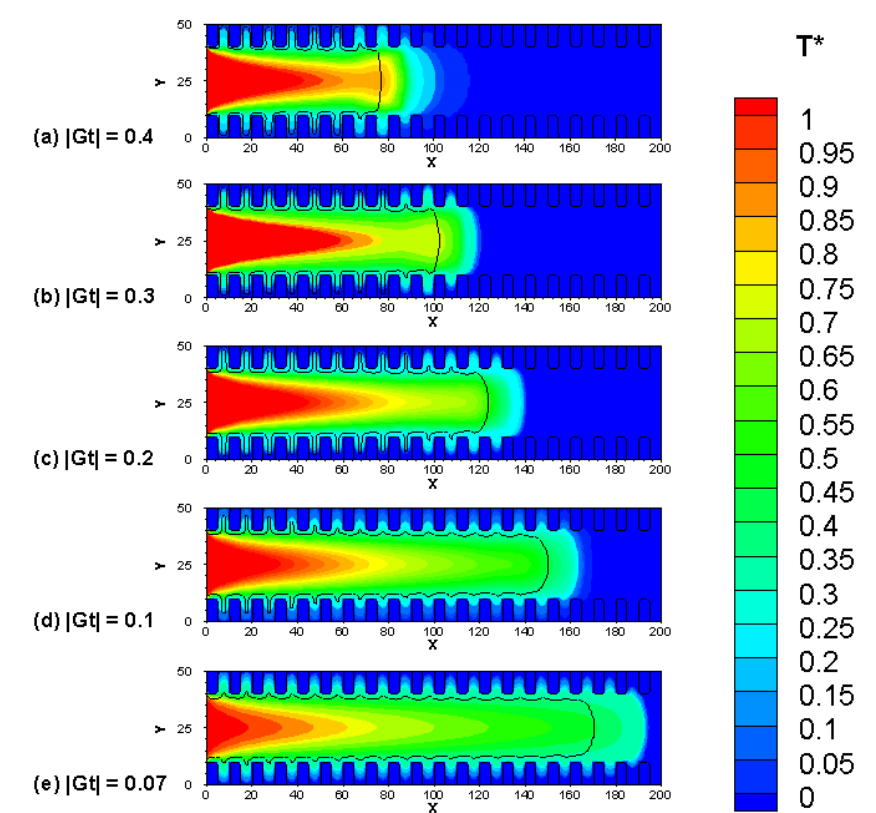
Figure 7. Dimensionless temperature distributions of channel flow with rough surfaces at the 400th step ( 6.0  G